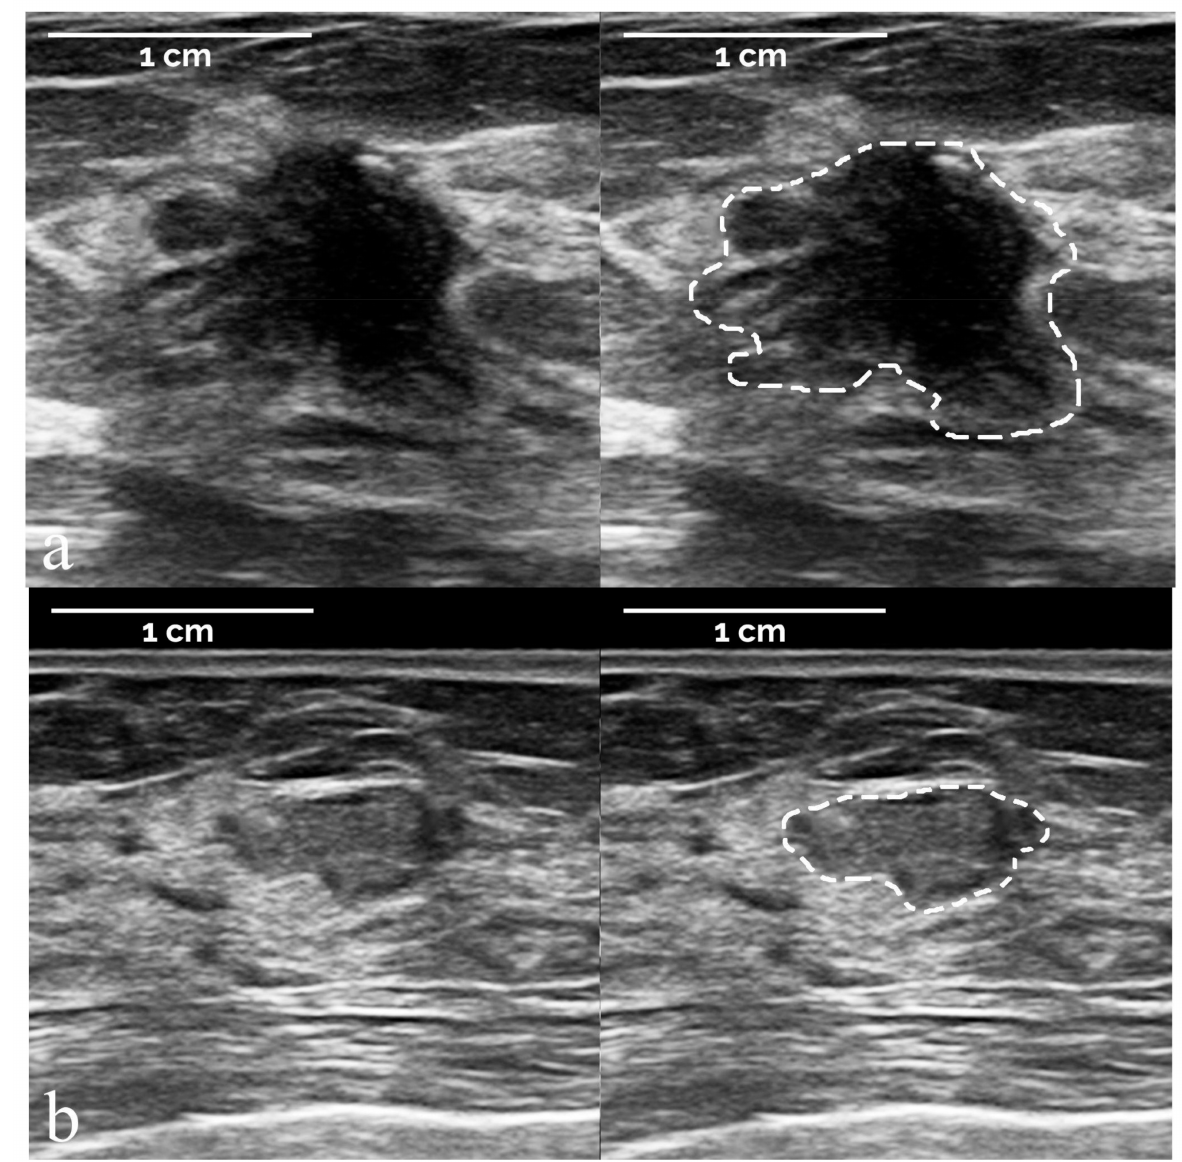
Figure 4. Representative examples of two malignant lesions according to histological diagnosis, as classified by the developed radiomic machine learning system. First row ( a ): true positive (malignant lesion correctly classified as >2% likelihood of cancer); second row ( b ): false negative (malignant lesion incorrectly classified as <2% likelihood of cancer). ROIs were manually defined by the expert breast radiologist to segment the suspicious breast lesion. Radiomic features: ( a ) compactness 0.569; acircularity 0.326; center of mass shift 3.997; zone size non-uniformity 2600.2; ( b ) compactness 0.614; acircularity 0.276; center of mass shift 5.861; zone size non-uniformity 2209.0. Histopathology: ( a ) invasive ductal carcinoma; ( b ) papillary